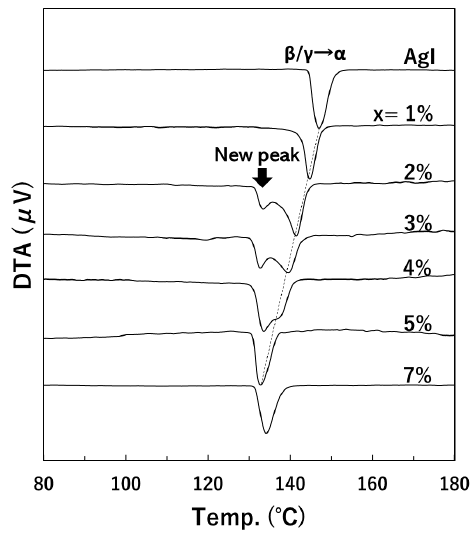
Figure 5. Differential thermal analysis curves of x Ag 2 CO 3 –(1 − x ) AgI. The samples were not subjected to uniaxial pressing treatment.